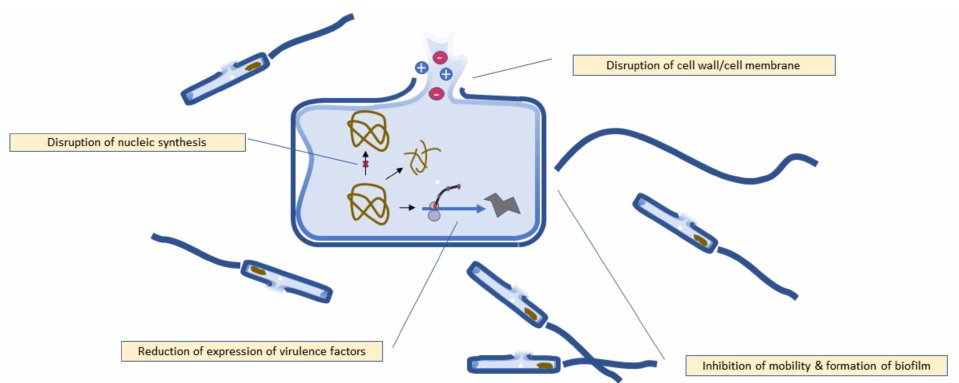
Figure 2. Antibacterial mechanism of quercetin.